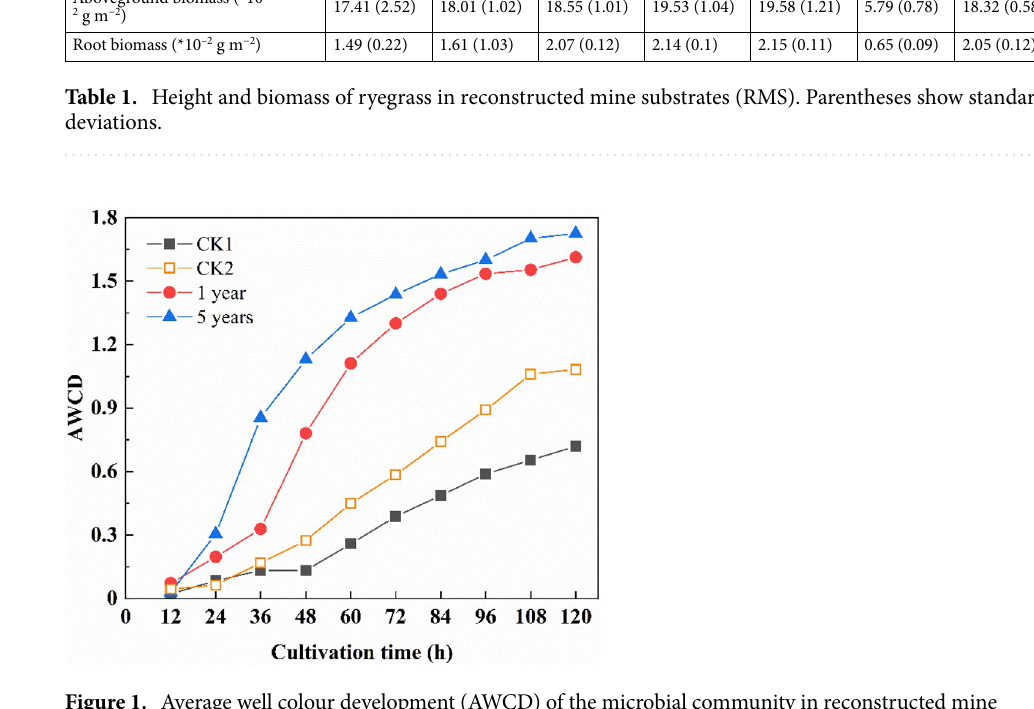
Figure 1. Average well colour development (AWCD) of the microbial community in reconstructed mine substrates (RMS) for different